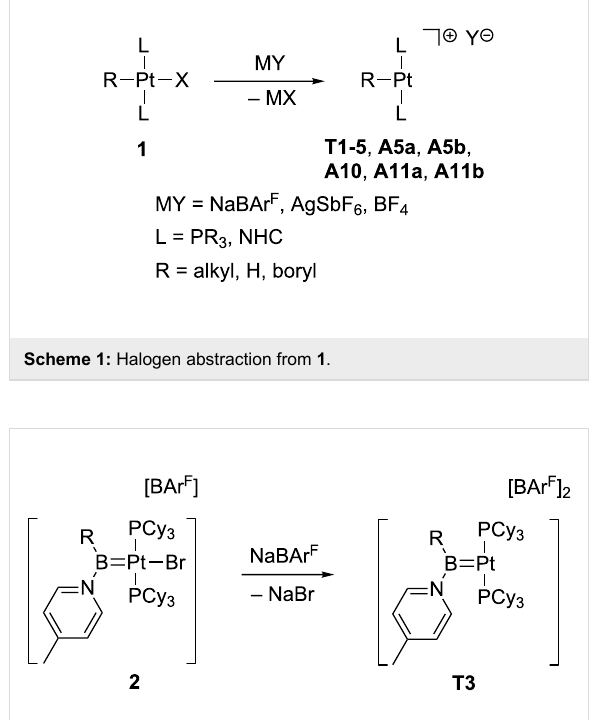
( A11b· NCMe) shows resonances for the Pt–CH 2 fragment with 2 J 1 J Pt,H and Pt,C values of 87 and 798 Hz, respectively